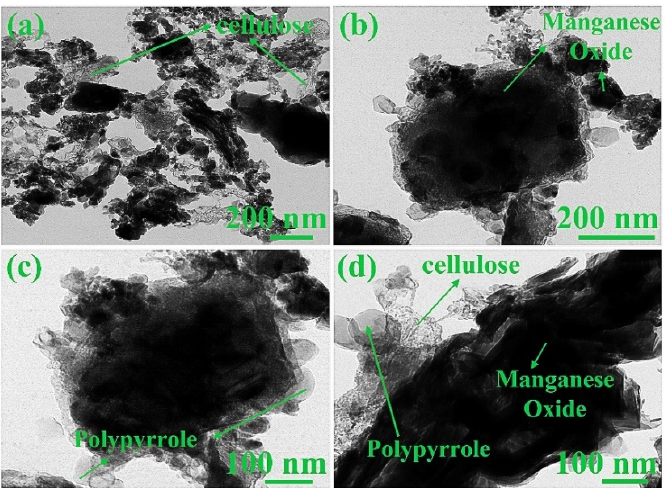
Figure 10. FE-TEM images of MnO 2 @CE/PPy at the magnification of ( a ) 200 nm, ( b ) 200 nm, ( c ) 100 nm, and ( d ) 100